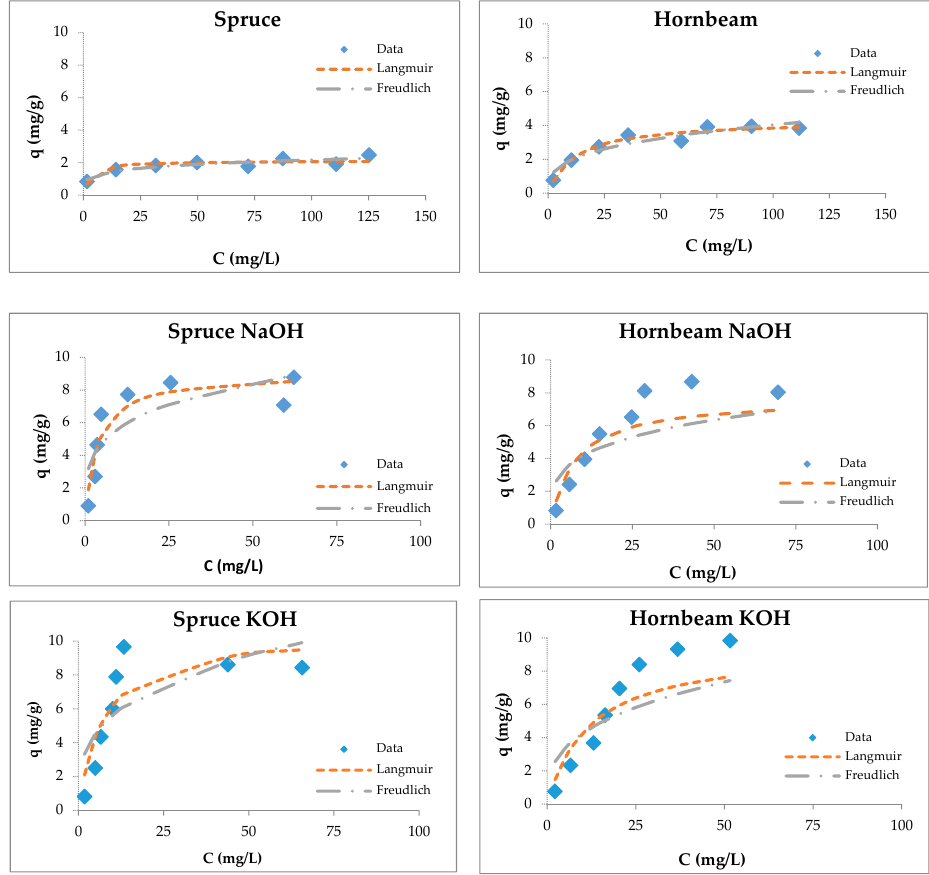
Figure 5. Langmuir and Freundlich isotherms of Cu(II) removal by raw and modified sawdusts.